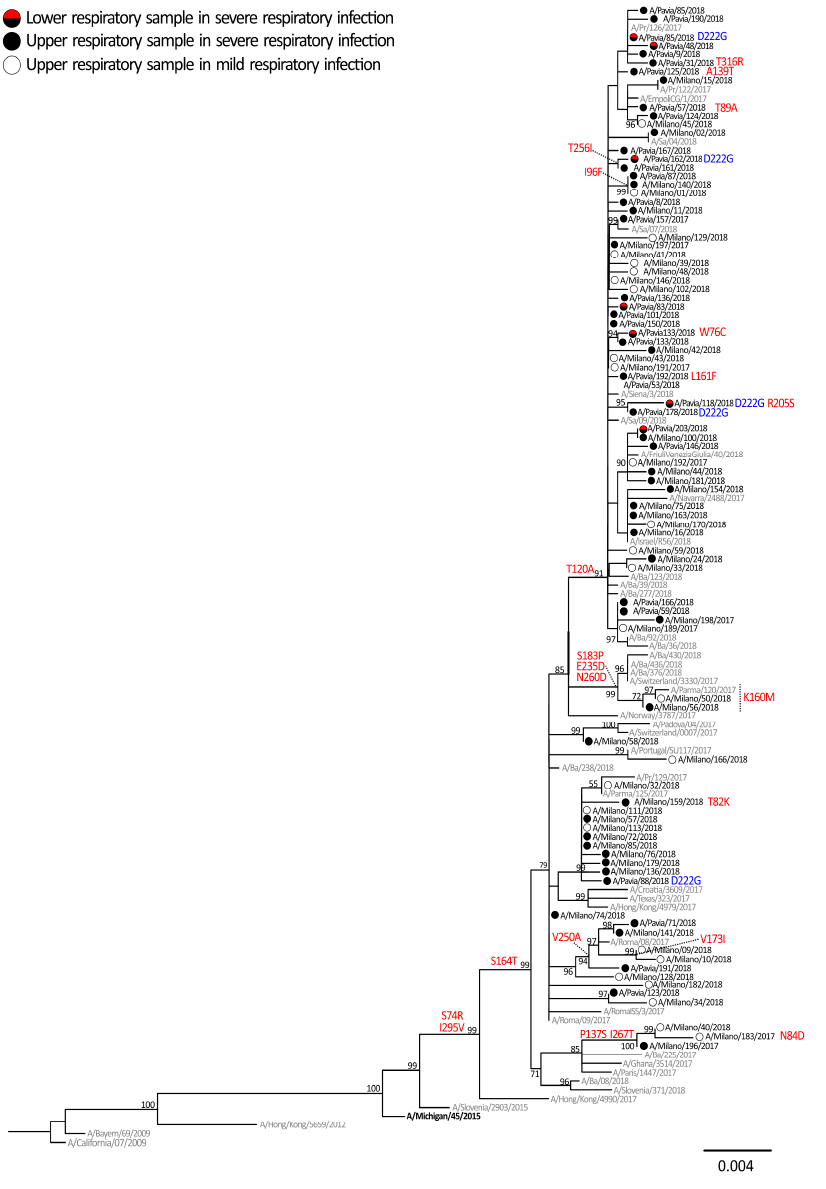
Figure 2. Phylogenetic tree of hemagglutinin (HA) sequences of A / H1N1pdm09 viruses, which was inferred by using the maximum likelihood. The percentage of replicate trees in which the associated taxa clustered together in the bootstrap test (1000 replicates) is shown next to the branches. A / H1N1pdm09 sequences originally identified in this study are reported with black circles (upper respiratory tract (URT) sample of severe cases), red / black circles (lower respiratory tract (LRT) samples of severe cases) and white circles (URT samples of mild cases). The 2017–2018 A / H1N1pdm09 vaccine strain is reported in bold and reference strains are reported in grey. Amino acid mutations are reported in red, mutations at codon 222 are in blue.